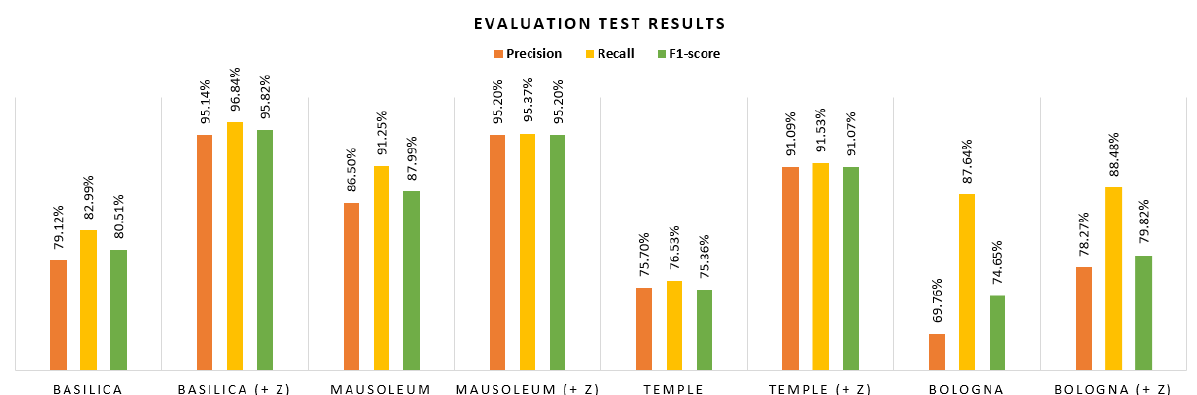
Table 7. Summary of the classification results after the extraction of a few features ad hoc. All the classification processes were run with and without the use of the height information (Z